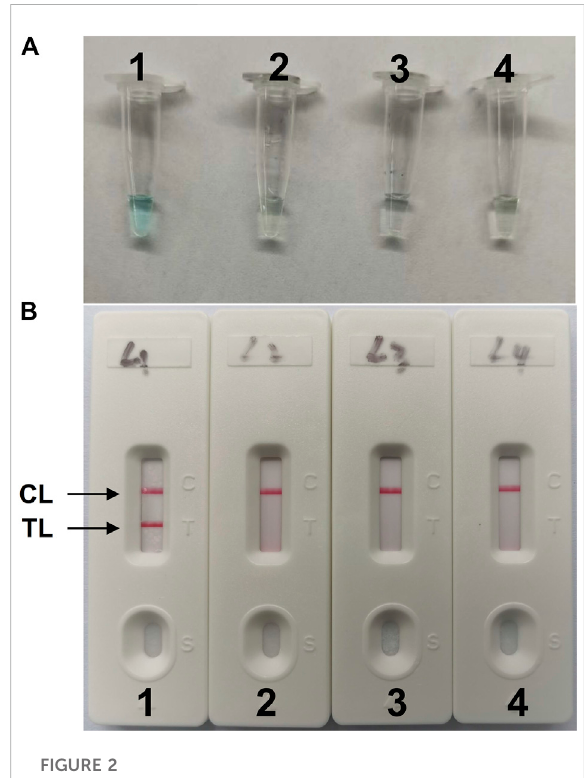
FIGURE 2 Detection and validation of (C) albicans -LAMP products (A) , Colorchangeof C.albicans -LAMPtubes; (B) ,biosensorappliedfor visual detection of C.albicans -LAMP products. Tube A1 (biosensor B1), positive ampli fi cation; tube A2 (biosensor B2), negative ampli fi cation ( Candida tropicalis ), tube A3 (biosensor B3),